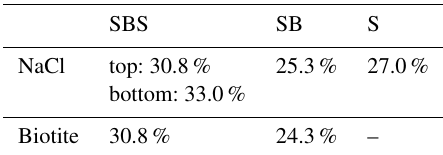
Table 3. Starting porosity of individual layers after 1h of com- paction.